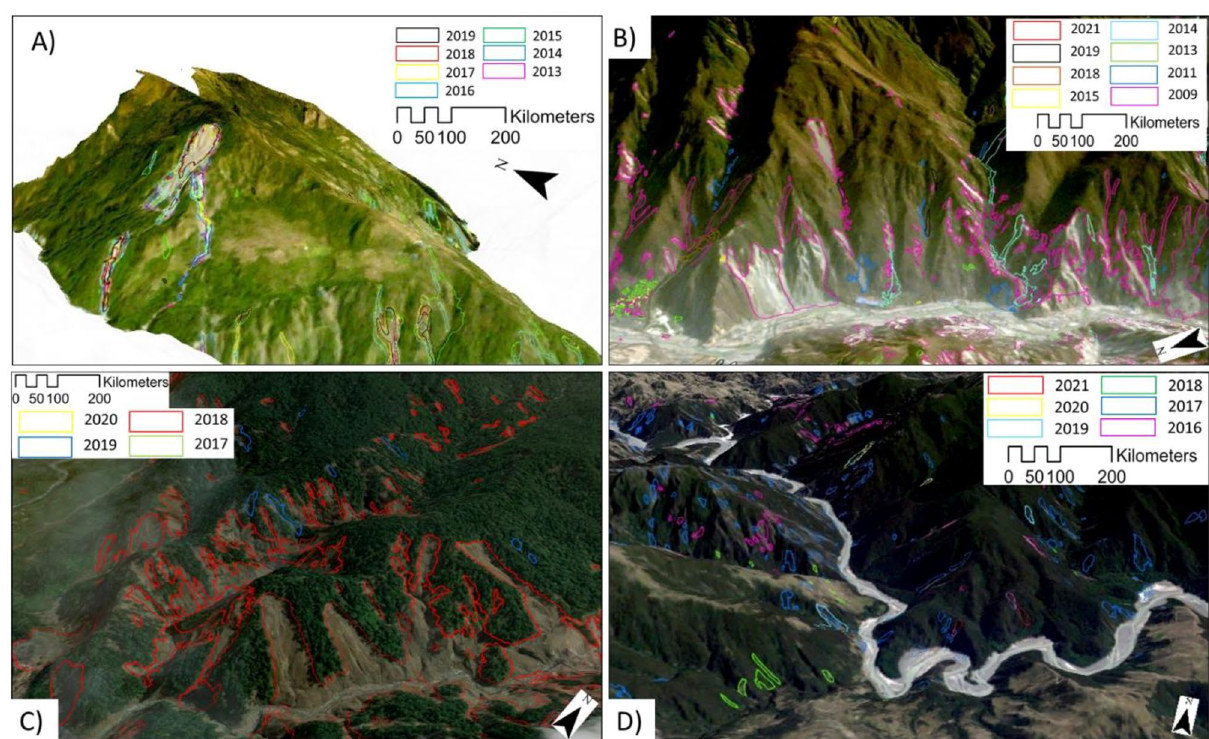
Figure 3. 3D oblique view examples of temporal evolution of the landslides in ( A ) Nepal, ( B ) China, ( C ) Papua New Guinea, and ( D ) New